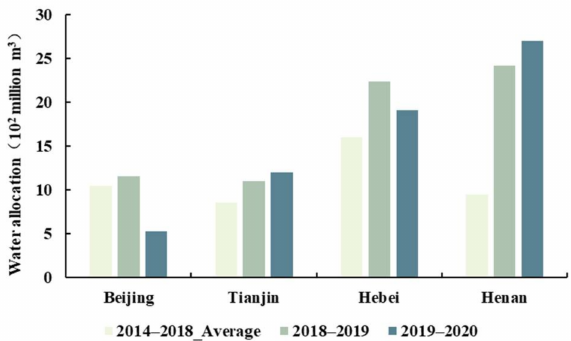
Figure 4. Water allocation for each province of SNWD.